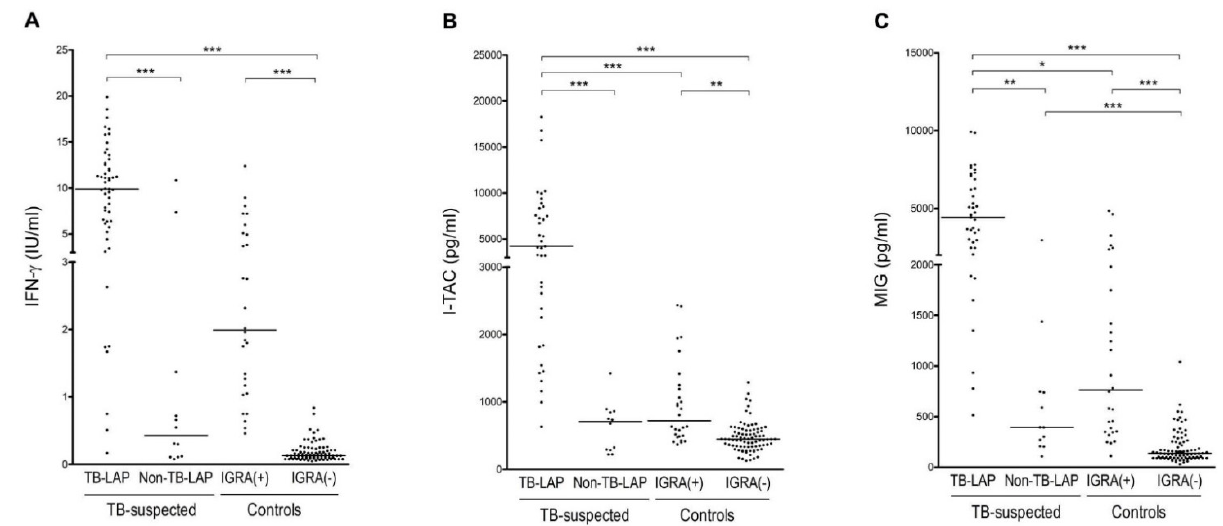
Figure 3. Comparison of tuberculosis-antigen-stimulated ( A ) interferon (IFN)- γ , ( B ) IFN-inducible T cell α chemoattractant (I-TAC), and ( C ) monokine induced by IFN- γ (MIG) levels among definite tuberculous lymphadenopathy (TB-LAP) patients ( n = 39), non-tuberculous lymphadenopathy (Non-TB-LAP) patients, and IFN- γ release assay (IGRA)-positive and -negative control groups. Horizontal lines represent median values. * p < 0.05; ** p < 0.01; *** p < 0.001 (Kruskal–Wallis analysis with Dunn’s comparison test).